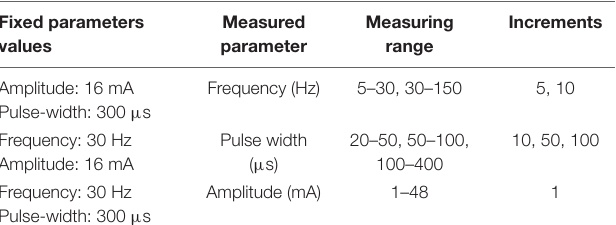
Measured Measuring parameter